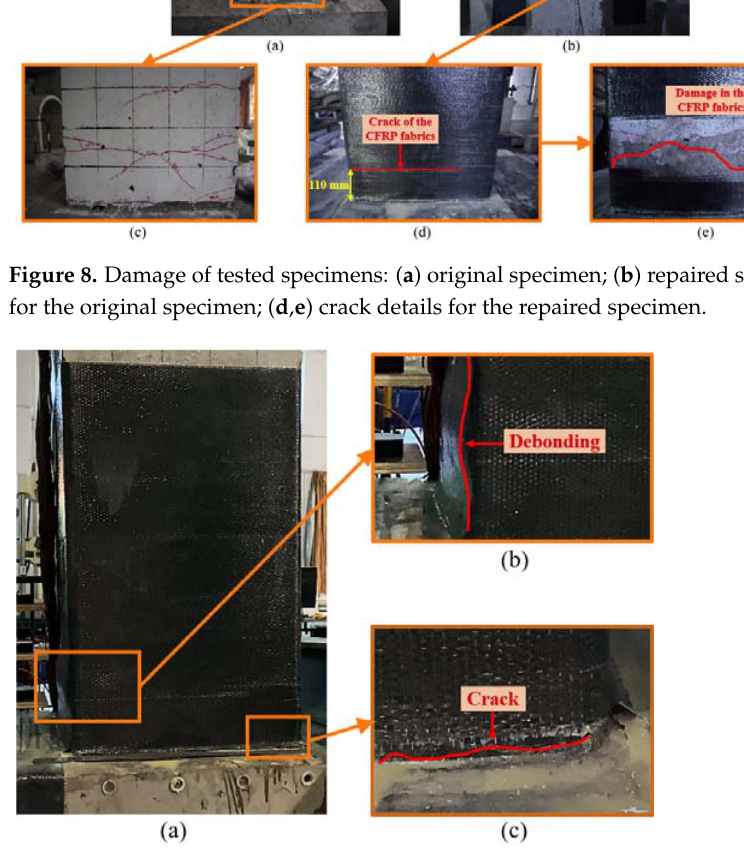
80 Figure 10. Load–displacement curves.